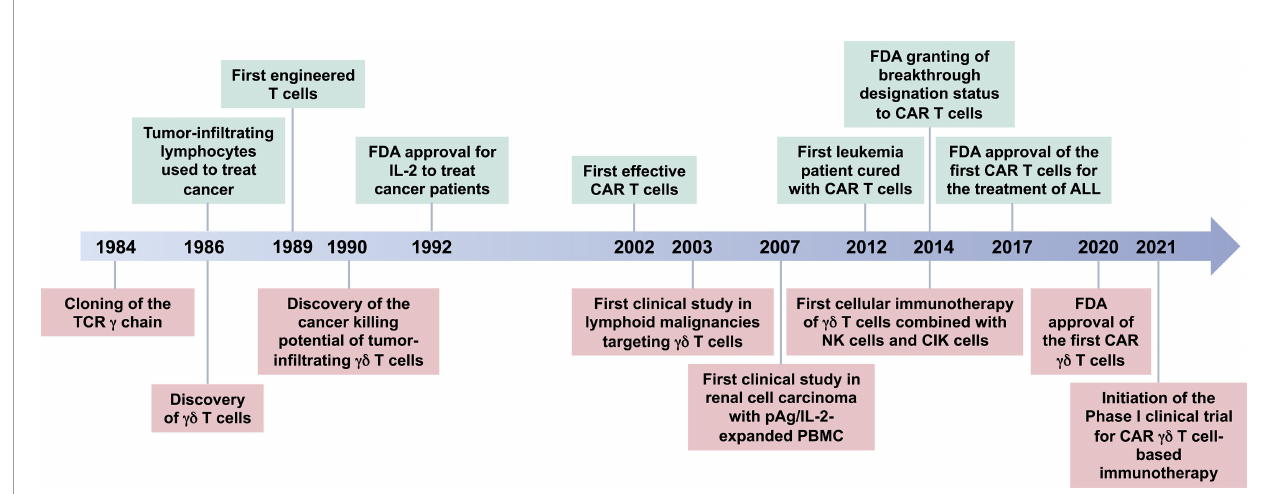
FIGURE 1 | Timeline for gd T-cell-based immunotherapy. A brief history of the breakthrough fi ndings that led to the development of gd T cell-based immunotherapies. gd T cells were discovered in 1986 (126, 127), after accidental cloning of the gamma chain of the T cell receptor (TCR) in 1984 (128). At the same time, Rosenberg ’ s group started to treat cancer patients with their own tumor-in fi ltrating lymphocytes leading to the fi rst patient to be cured from cancer using this method (129, 130). Fast forward from 1989 to year 2017 (131 – 137), the FDA approved the fi rst CAR T cells for the treatment of B-cell lymphomas, Kymriah ® and Yescarta ® developed by Novartis Pharmaceuticals Corp. (https://www.hcp.novartis.com/home/) and Kite Pharma, Inc. (https://www.kitepharma.com/), respectively. The fi rst big success came in 2020 for CAR therapy with gd T cells, when the FDA cleared an investigational new drug (IND) application and orphan drug designation for GDX012 (an allogenic V d 1 T-cell-based therapy) developed by Lymphact and later GammaDelta Therapeutics (https://gammadeltatx.com/). Also, at the same time, the Adicet Bio (https://www.adicetbio.com/) received the FDA approval for an IND application ADI-01, an allogenic CAR gd T cell therapy targeting CD20 protein in non-Hodgkin lymphomas. In 2021, the fi rst Phase I Clinical Trials of gd T-cell-based immunotherapies were initiated. TCR, T-cell receptor; FDA, The United States Food and Drug Administration; IL-2, interleukin-2; CAR, chimeric antigen receptor; pAg, phosphoantigen; PBMC, peripheral blood mononuclear cells; ALL, acute lymphoblastic leukemia; NK cells, natural killer cells; CIK cells, cytokine-induced killer